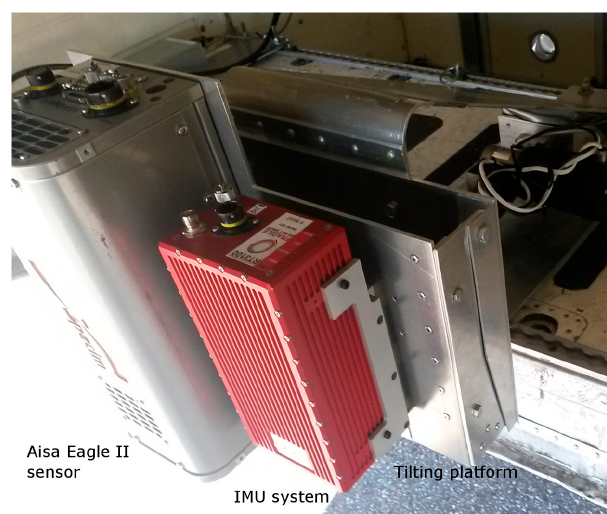
Figure 1. Hyperspectral AISA Eagle II sensor and IMU system on a tilting platform looking in the nadir direction through the cargo bay entrance at the rear of the aircraft. The cables connecting the instruments have been removed for better visibility. We configured the sensor to scan with a 60 Hz framerate. The chosen configuration resulted in square pixels of approximately 60 cm for nadir view; in off-nadir directions, the pixels were slightly elongated (Table 1). Full technical characteristics of the sensor are given in Table 2. Table 1. Scene and data acquisition parameters.